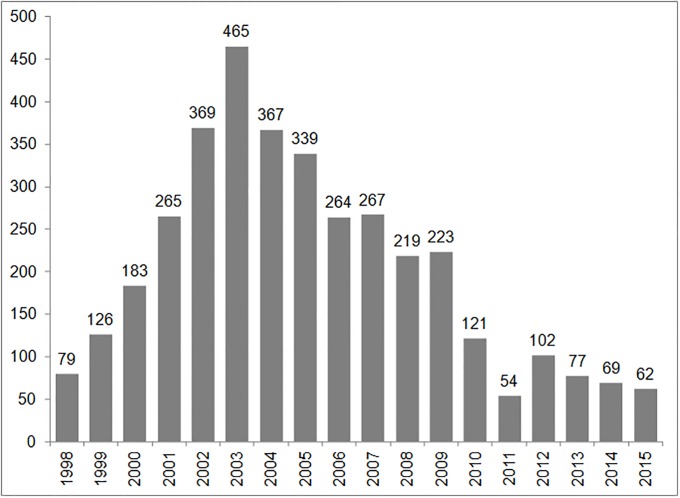
Number of entries of ARV-naïve patients by year, CTA, Dakar, Senegal.